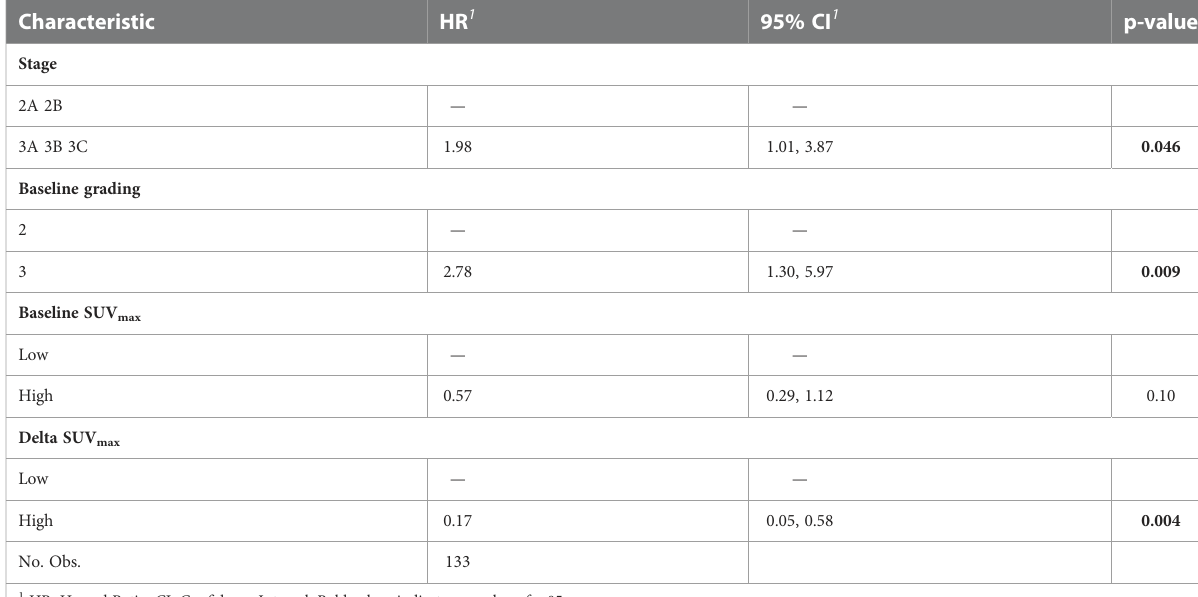
TABLE 5 Multivariable Cox proportional hazard model of the clinicopathological characteristics and metabolic parameters for DFS. Characteristic HR 1 95% CI